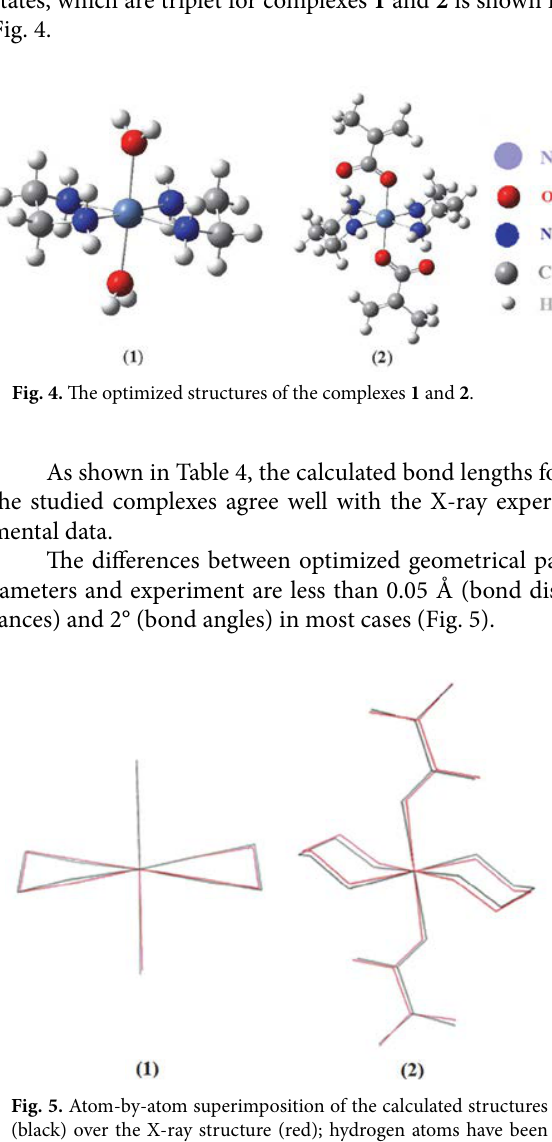
Fig. 3. Various hydrogen bonding interactions in complexes 1 and 2 , other hydrogen atoms are omitted for clarity.